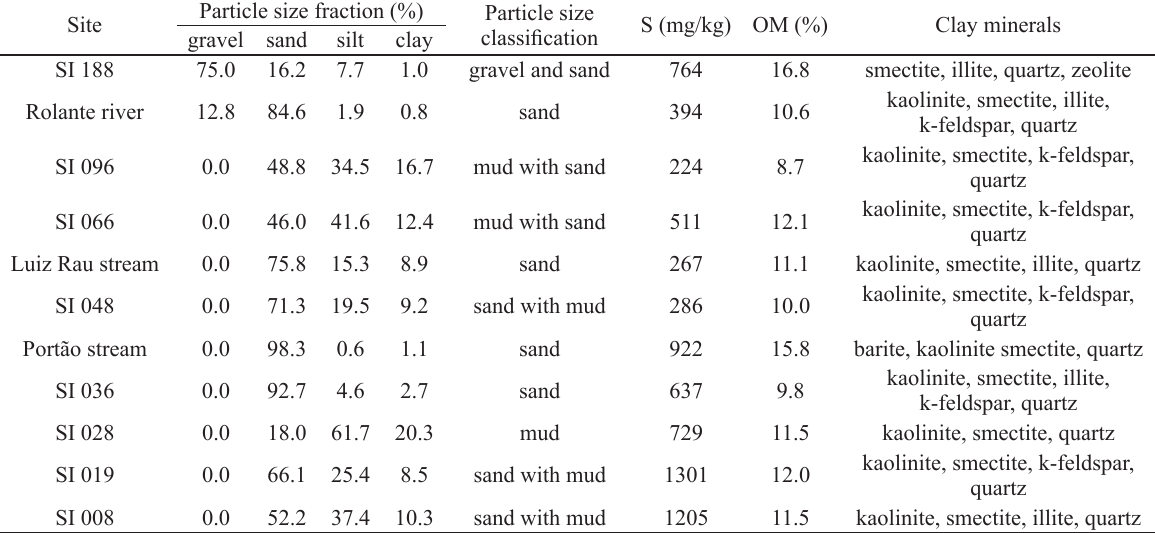
Additional parameters used for characterizing sediment samples from the Sinos River